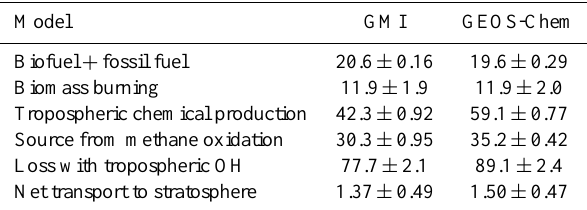
Table 2. Annual mean and interannual standard deviation of CO budgets (biofuel and fossil fuel emissions, biomass burning emis- sions, tropospheric chemical production, tropospheric methane ox- idation, loss with tropospheric OH and net transport from tropo- sphere to stratosphere) for GMI and GEOS-Chem during 2004– 2012 (units in Tmolyear − 1